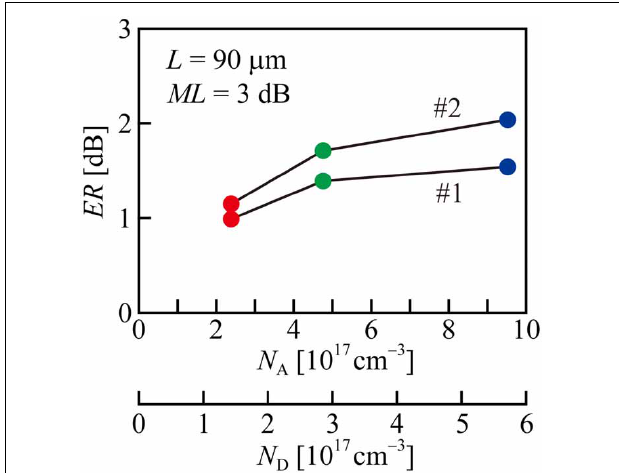
FIGURE 11 | Doping concentration of ER at 10-Gbps (2 31 –1 bits) for device #1 with linear junction and device #2 with interleaved junction ( w x = 300nm, w y = 600nm).